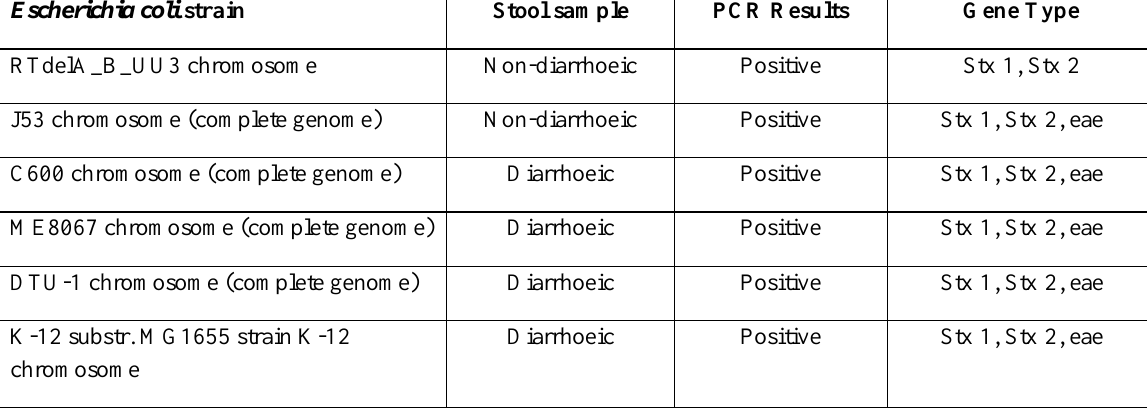
Table 4. Result of PCR of selected E.coli isolate among diarrhoeic and non-diarrhoeic stool.